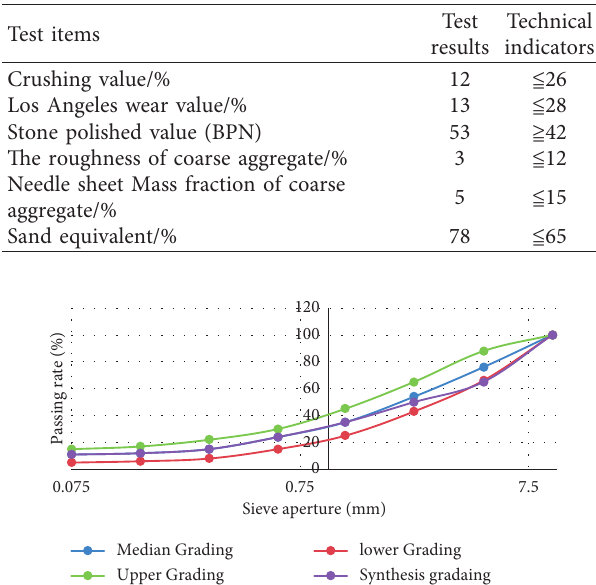
Table 1: Technical specifications of aggregate.